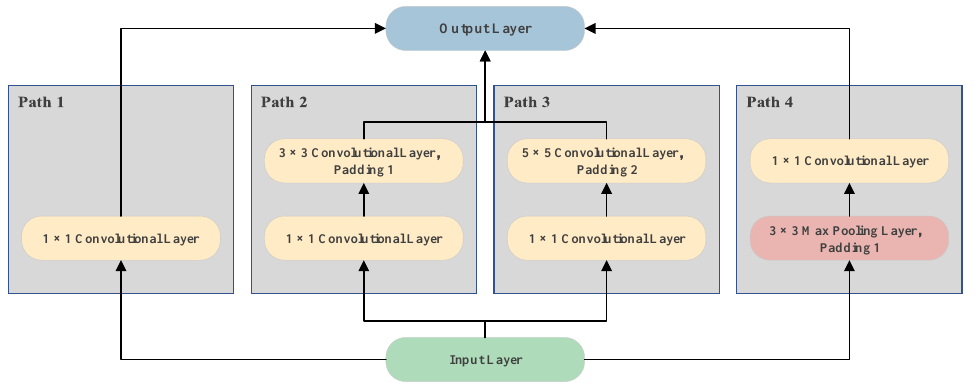
Figure 5. Schematic diagram of the inception block.